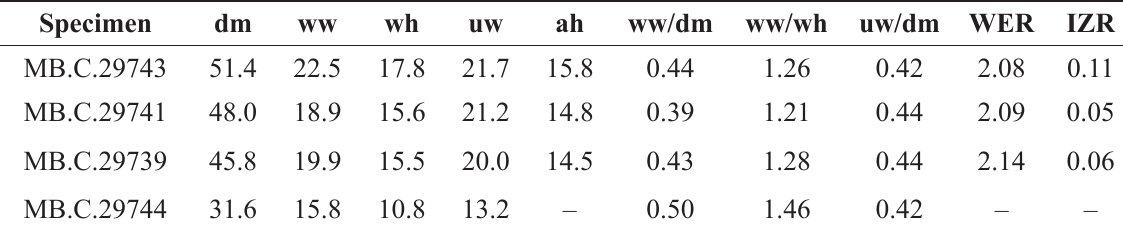
Table 7. Conch dimensions (partly estimated) and ratios of selected specimens of Dzhulfites spinosus Shevyrev, 1965 from Baghuk